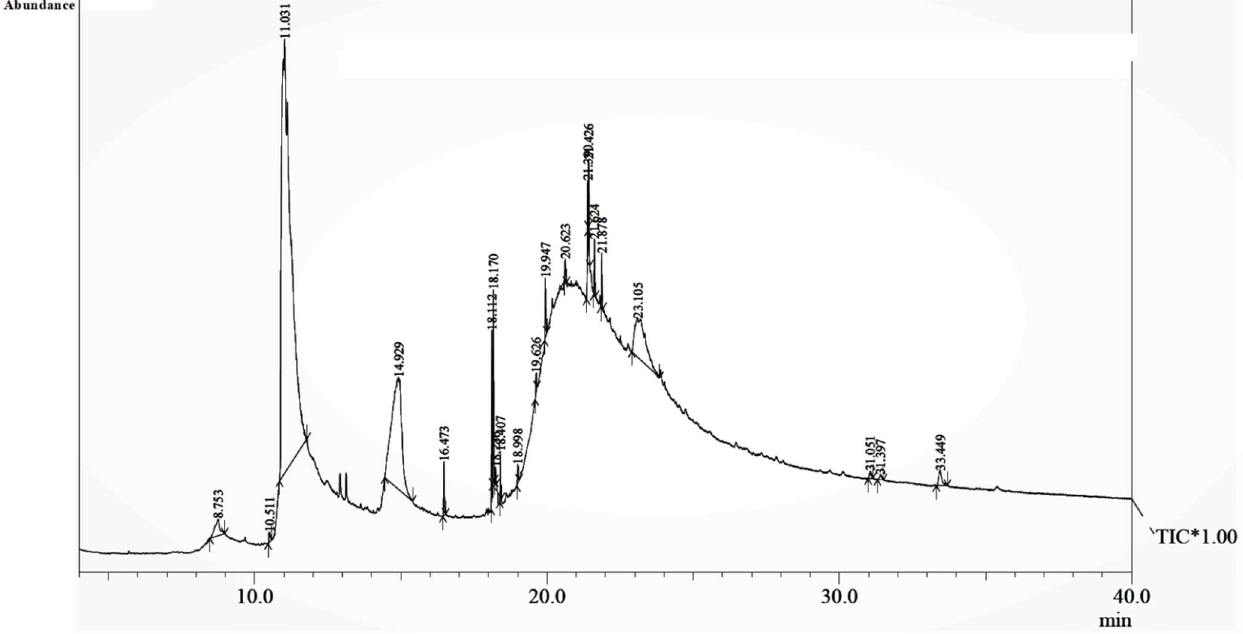
Figure 1. GC–MS chromatogram of methanolic extract of A. nilotica.